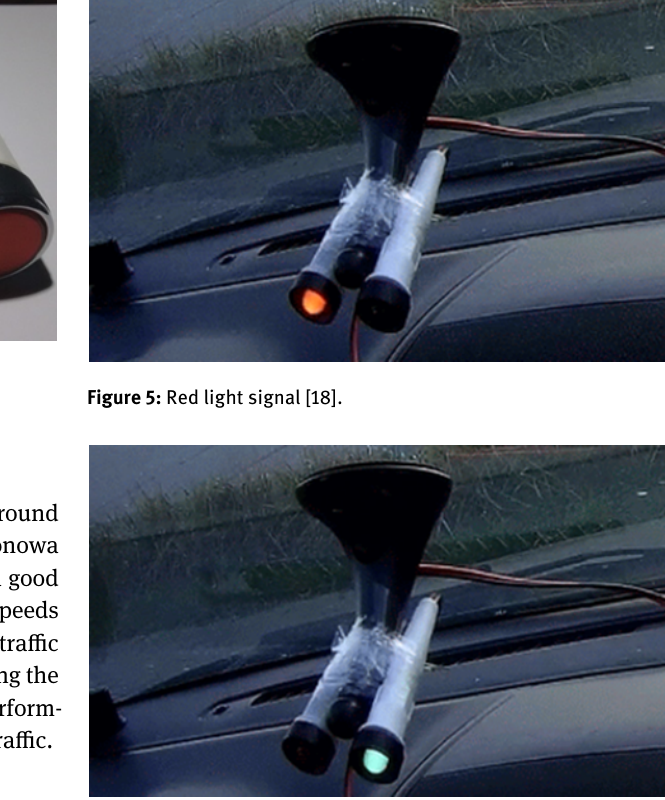
Figure 6: Green light signal